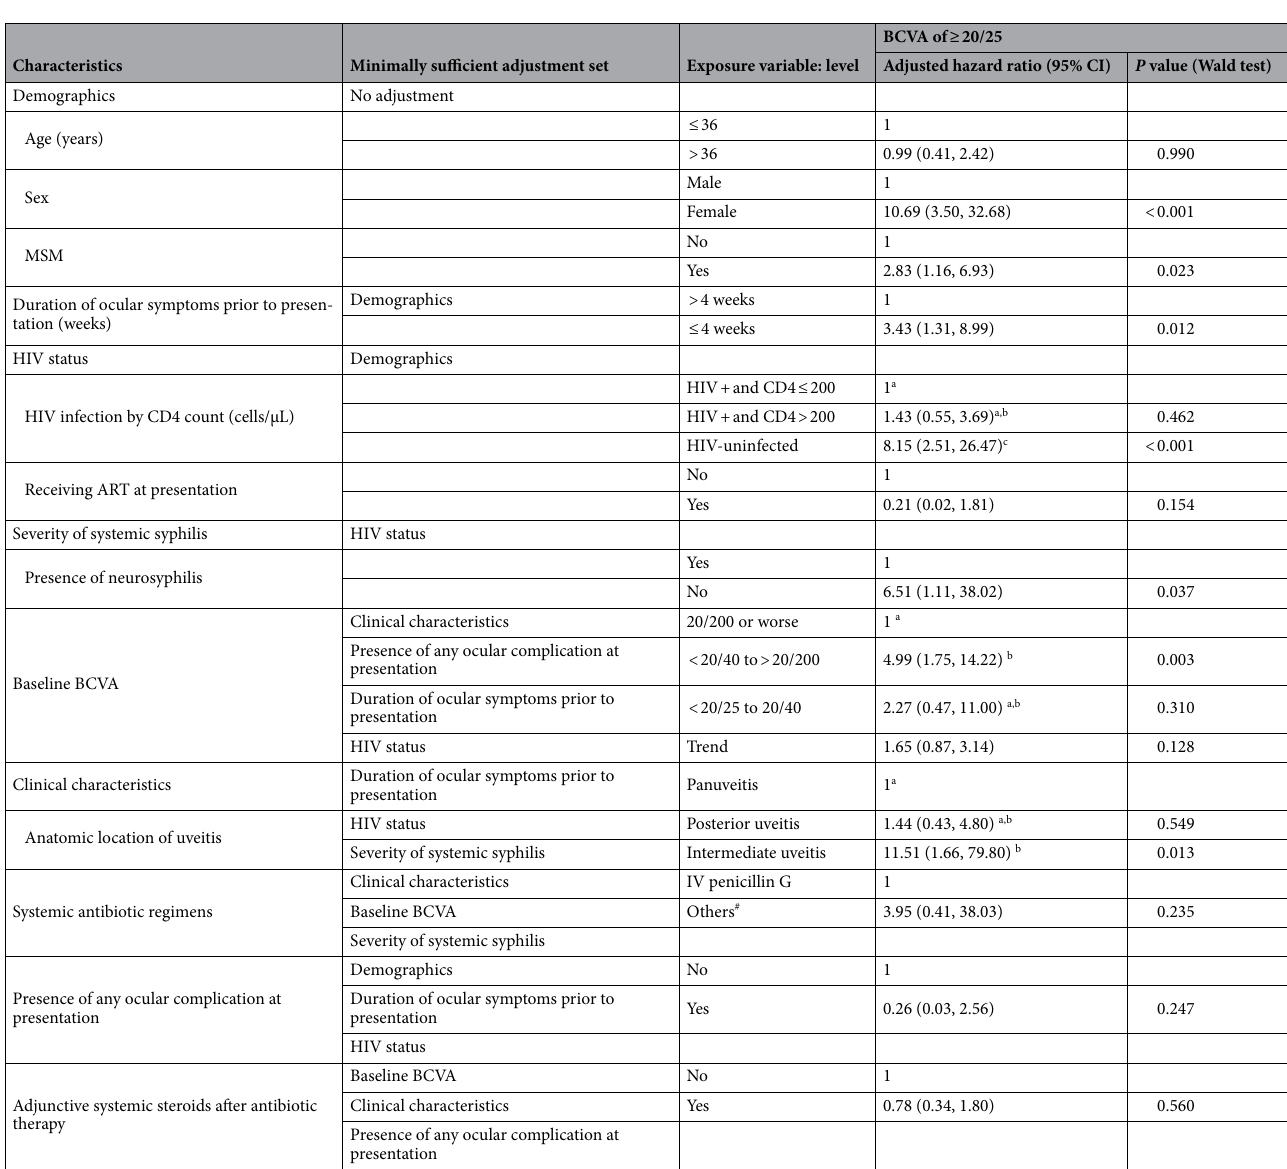
Table 5. Multivariate analyses by robust estimation of predictive factors associated with achieving BCVA of ≥ 20/25 following antibiotic therapy. The abc values in columns not having a superscript in common differ significantly (P < 0.05). # Others included ceftriaxone and azithromycin. ART: antiretroviral therapy;